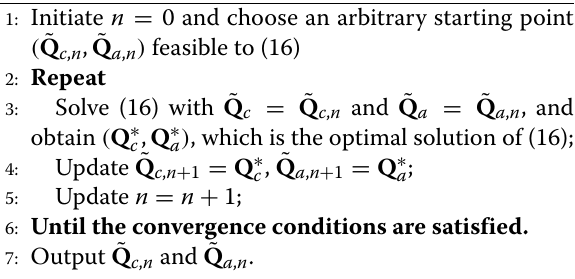
Algorithm 1. To acquire the secrecy rate region, we need to traverse τ ms lying within the interval [ 0, τ max ] and store the corresponding objective value of (16). Algorithm 1 Iterative method for solving